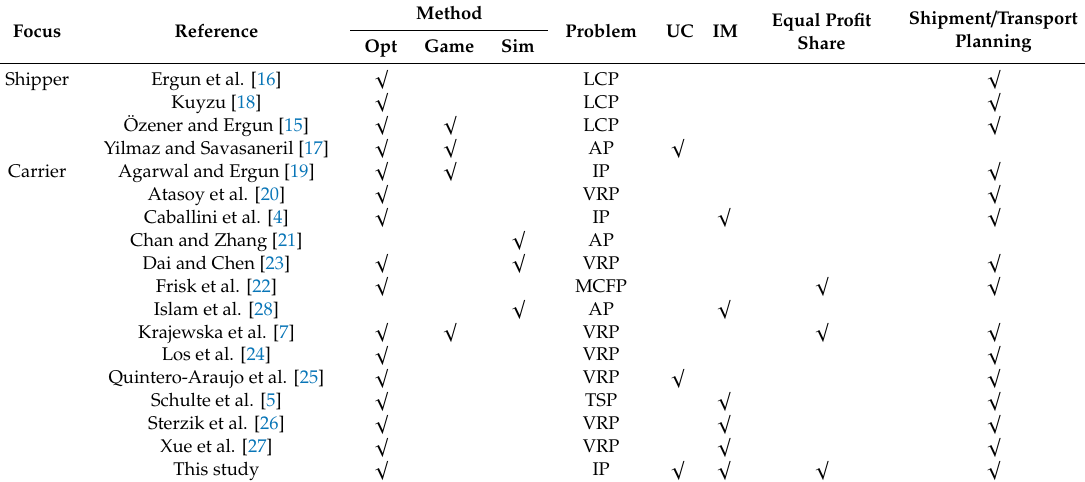
Table 1. Overview of related articles focused on freight-oriented horizontal